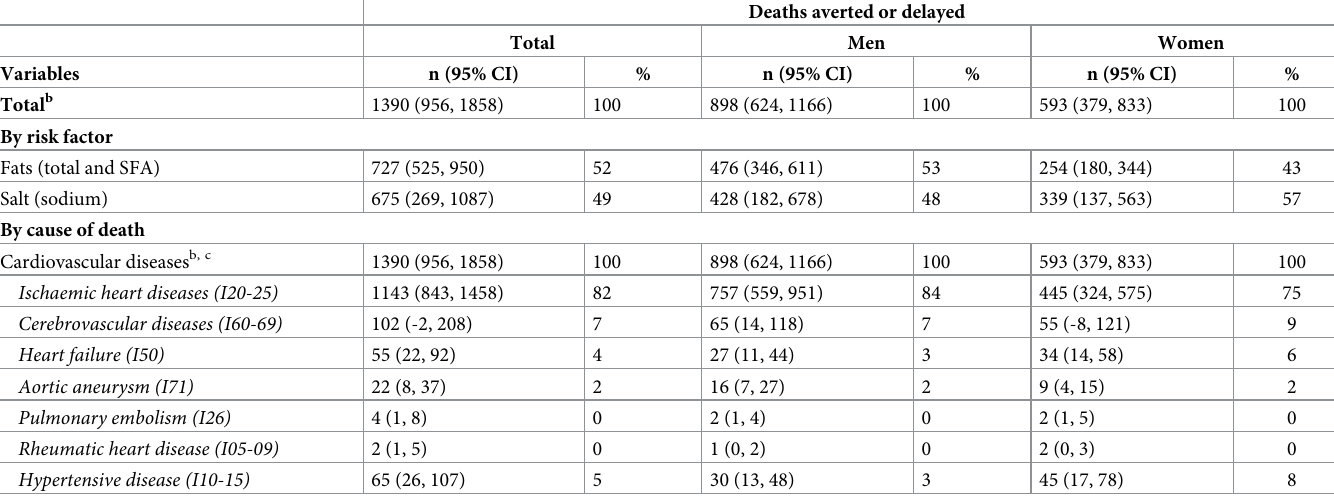
Table 2. Estimated number of deaths prevented per year under the traffic light labelling scenario, by diet-related risk factor and by cause, excluding the potential impact of changes in the population’s energy balance a